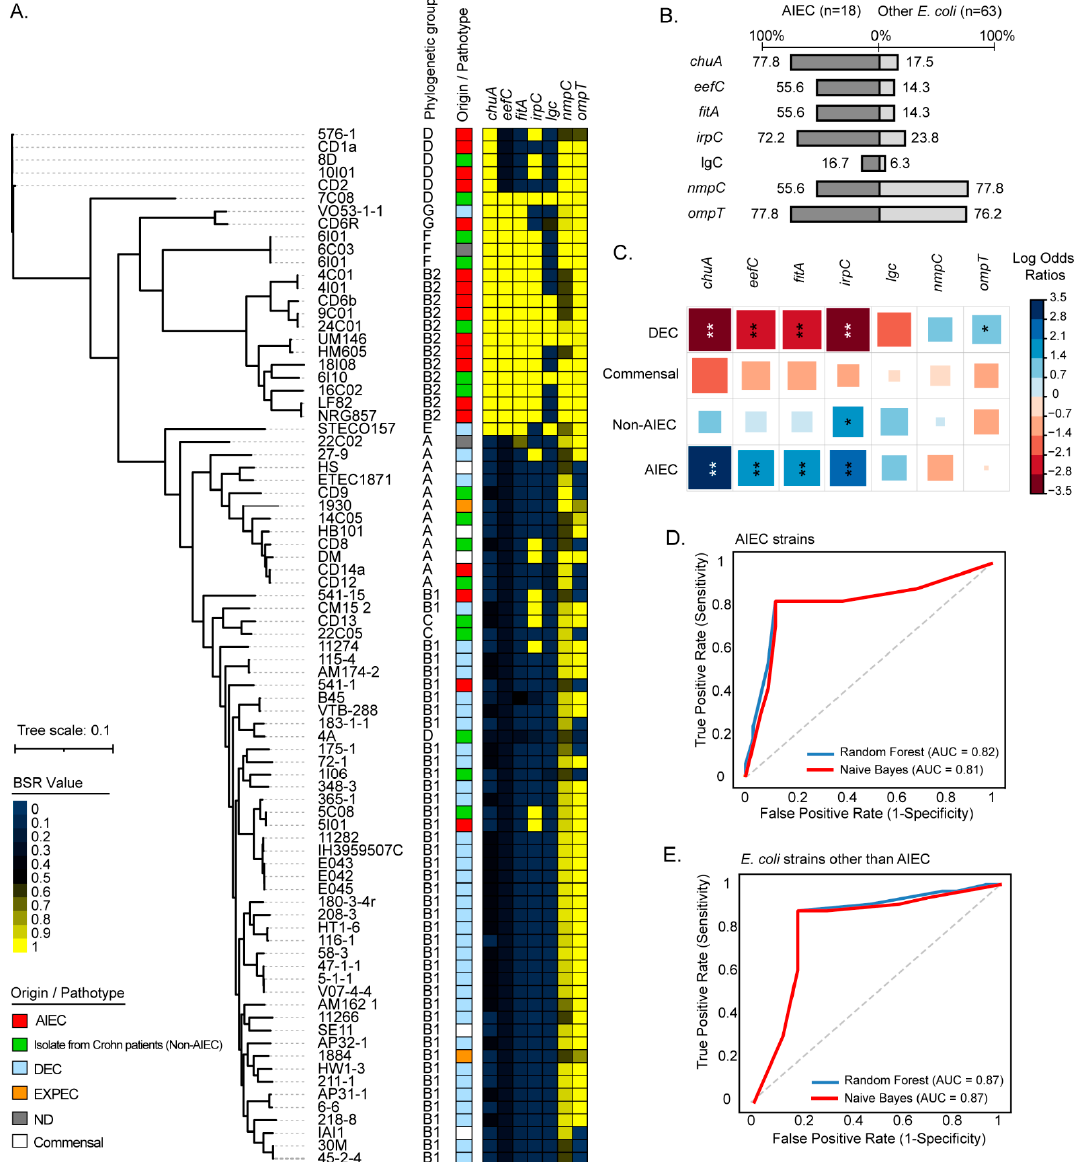
Figure 3. Phylogenetic distribution and prevalence of the chuA , eefC , fitA , irpC , lgC , nmpC , and ompT genes among AIEC strains. ( A ) The maximum parsimony phylogenetic tree (midpoint rooted) was based on 7515 core SNPs identified in 81 complete or draft genomic sequences of E. coli strains. Phylogenetic groups are indicated. The origin/pathotype of each isolate is indicated by colored boxes according to the legend. The presence, absence, and variation of each gene are indicated by the color scale, which represents the blast score ratio (BSR) values. A value of 1 indicates the presence of a gene encoding an identical protein. ( B ) Prevalence of the genes in AIEC and other E. coli strains. Numbers indicate gene prevalence in percentages in relation to the total strains in each group. ( C ) Pairwise association plot for pathotypes and the indicated genes. Red and blue squares represent negative and positive associations, respectively. The color scale represents the magnitude of the association determined by odds ratios. * p < 0.05, ** p < 0.005 determined by Pearson’s chi-square test or Fisher’s exact test. ( D , E ) Evaluation of the chuA , fitA , and eefC genes as molecular markers to discriminate AIEC strains from other E. coli strains. The random forest and naive Bayes classification methods were implemented. The performance of each classifier model is represented by ROC curves and the area under the curve